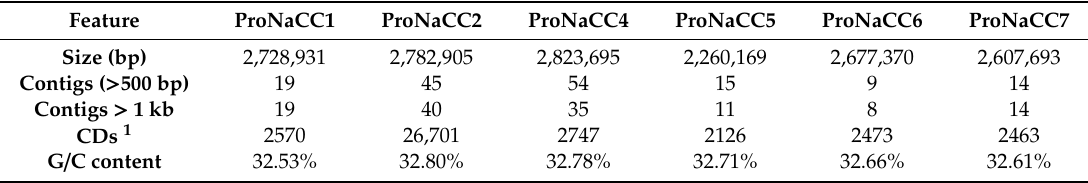
Table 5. Feature of the six sequenced genomes assembled with